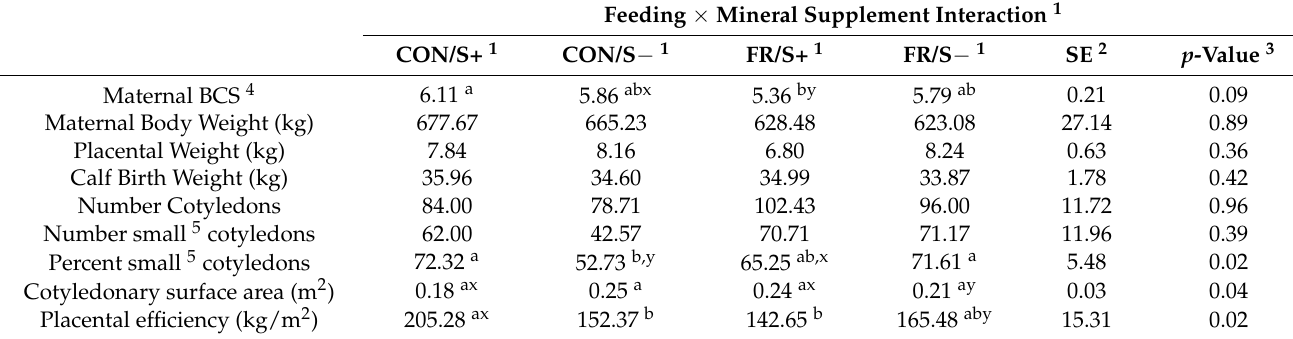
Table 2. Analysis of body weight, BCS, and placental efficiency characteristics in all treatments from the general linear model (GLM) for interactions between feeding treatment and mineral